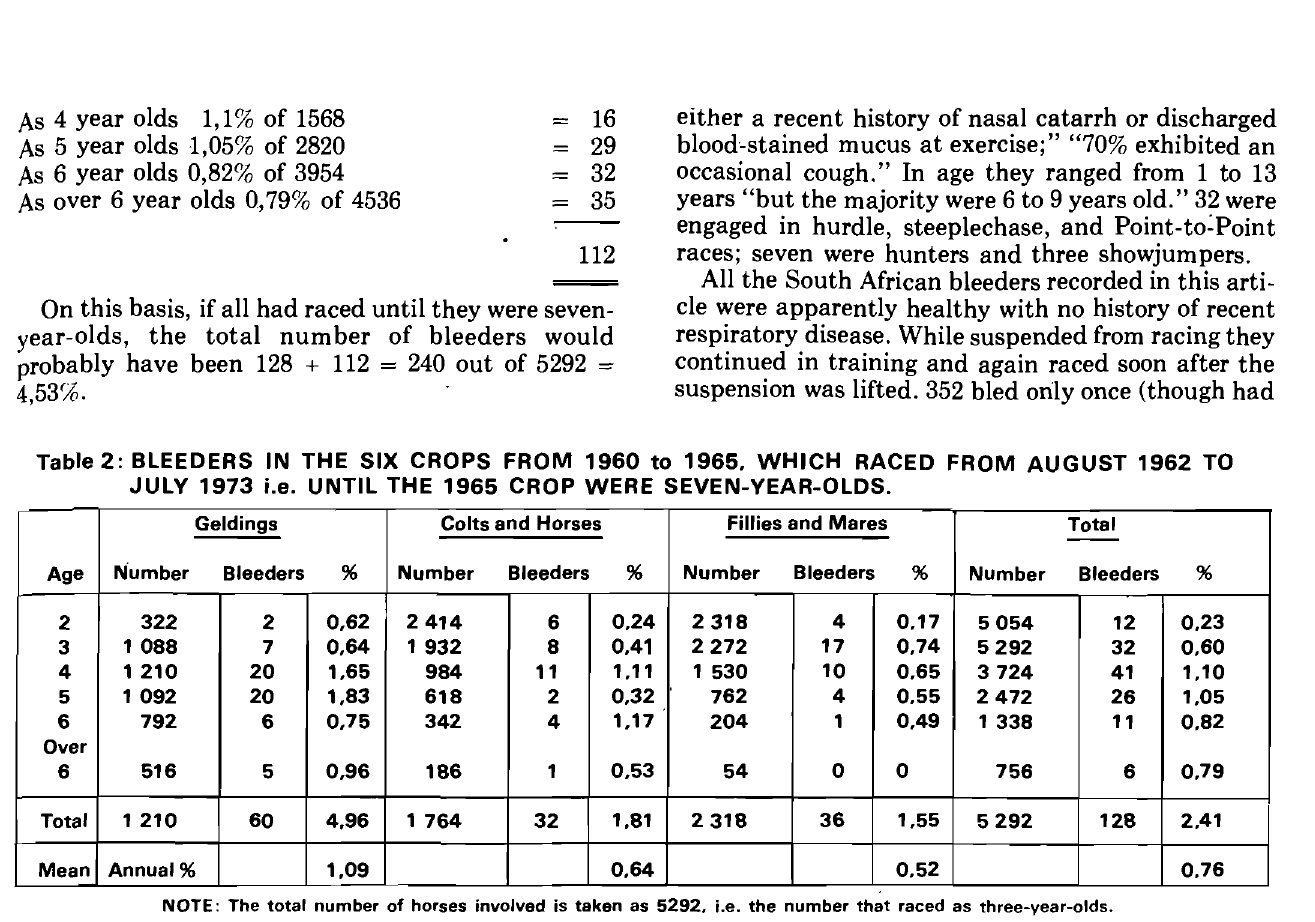
Table 2: BLEEDERS IN THE SIX CROPS FROM 1960 to 1965. WHICH RACED FROM AUGUST 1962 TO JULY 1973 i.e. UNTIL THE 1965 CROP WERE SEVEN-YEAR-OLDS. Geldings Colts and Horses Fillies and Mares Total -